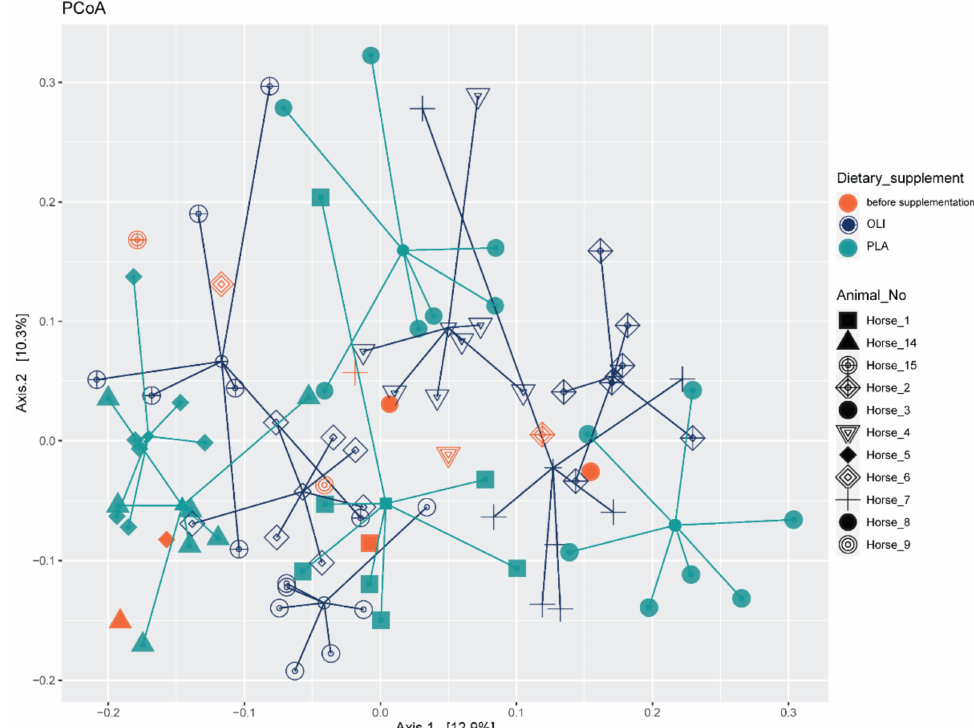
Figure 3. Bray–Curtis dissimilarity-based principal coordinate analysis (PcoA) was performed on fecal samples of horses. Different point shapes represent samples of a different horse; lines connect samples obtained from horses with the start of the experiment. Colors indicate the group membership (OLI = Olimond, PLA = Placebo). Samples marked in orange were taken before the start of the